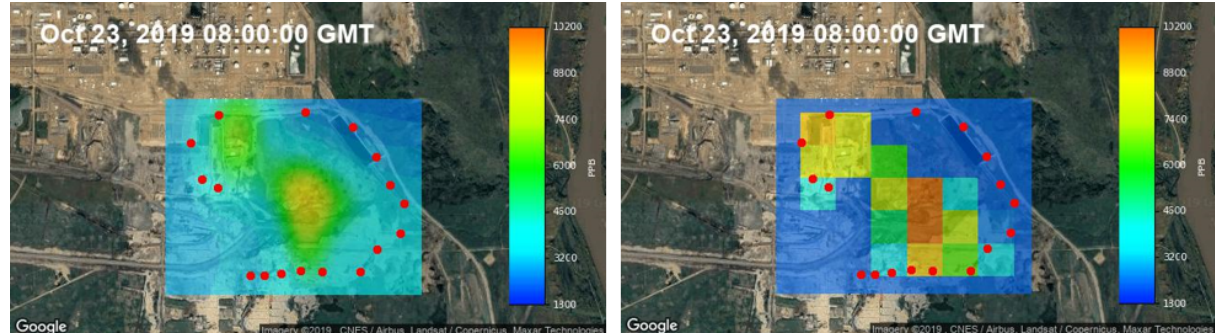
Figure 4. Example plume-based (left) and corresponding box-based (right) methane concentration reconstructions at the open-pit mine.